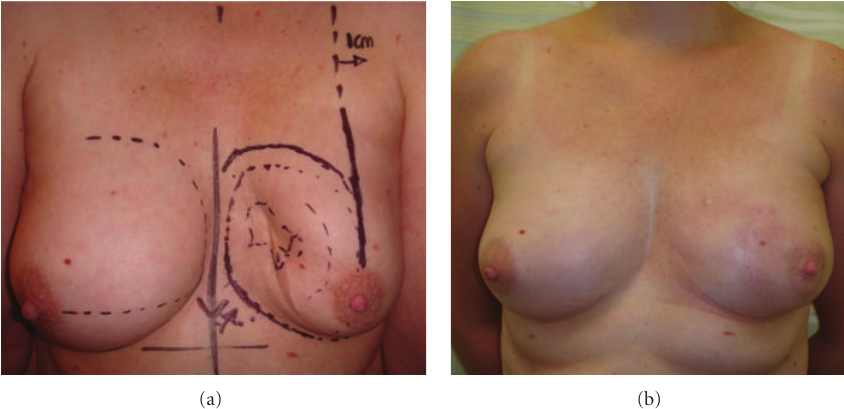
Figure 5: (a) This patient had previously undergone wide local excision and adjuvant radiotherapy for a cancer located in the lower inner quadrant of the left breast. The resulting defect causes significant distortion to the breast shape and nipple deviation toward the midline. (b) An omental flap was harvested laparoscopically in order to partially reconstruct the breast, achieving a high degree of symmetry with the contralateral